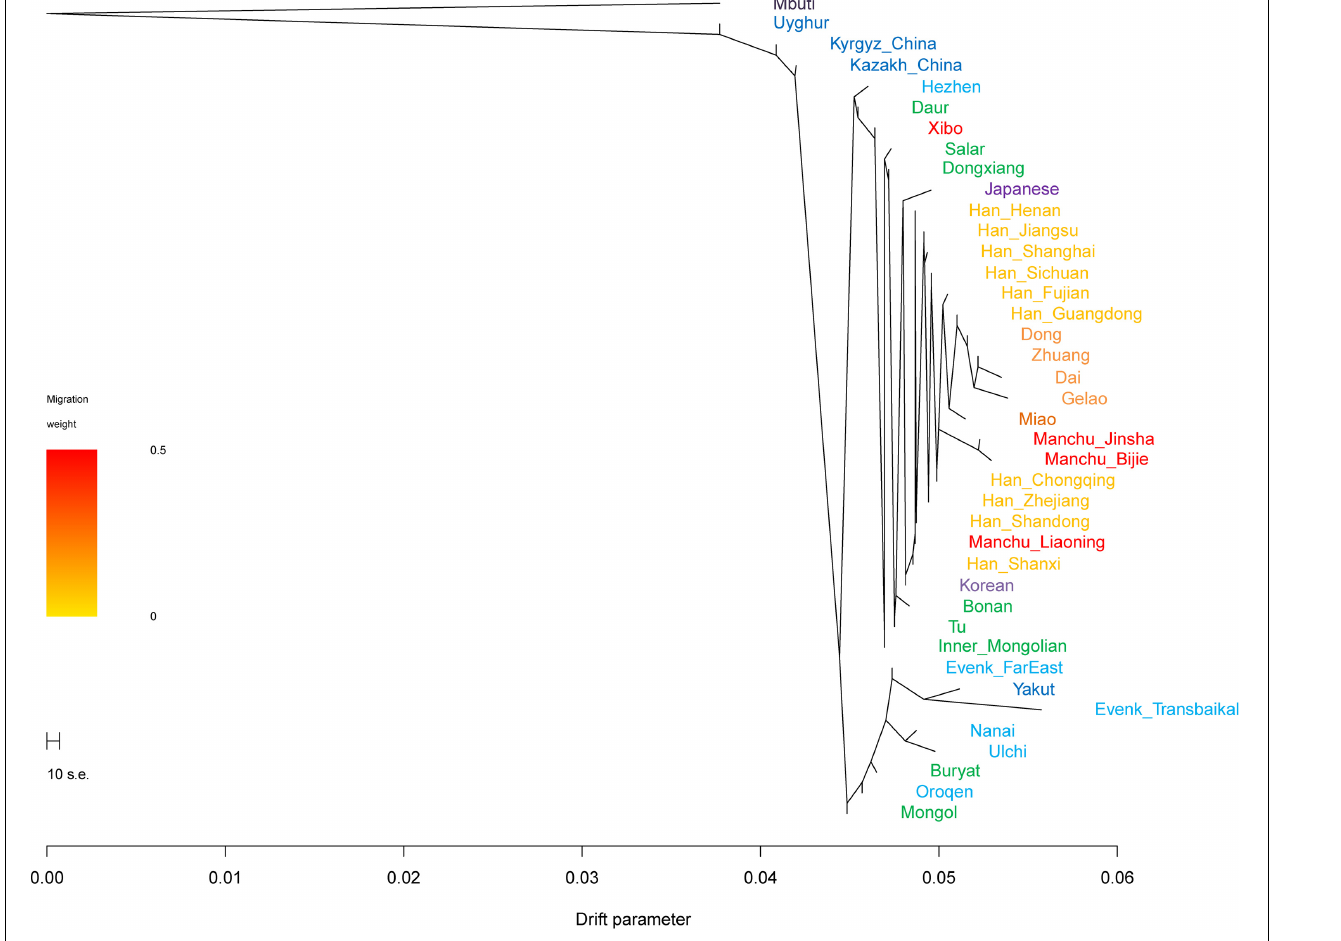
northern East Asians from the Yellow River and Western Liao River